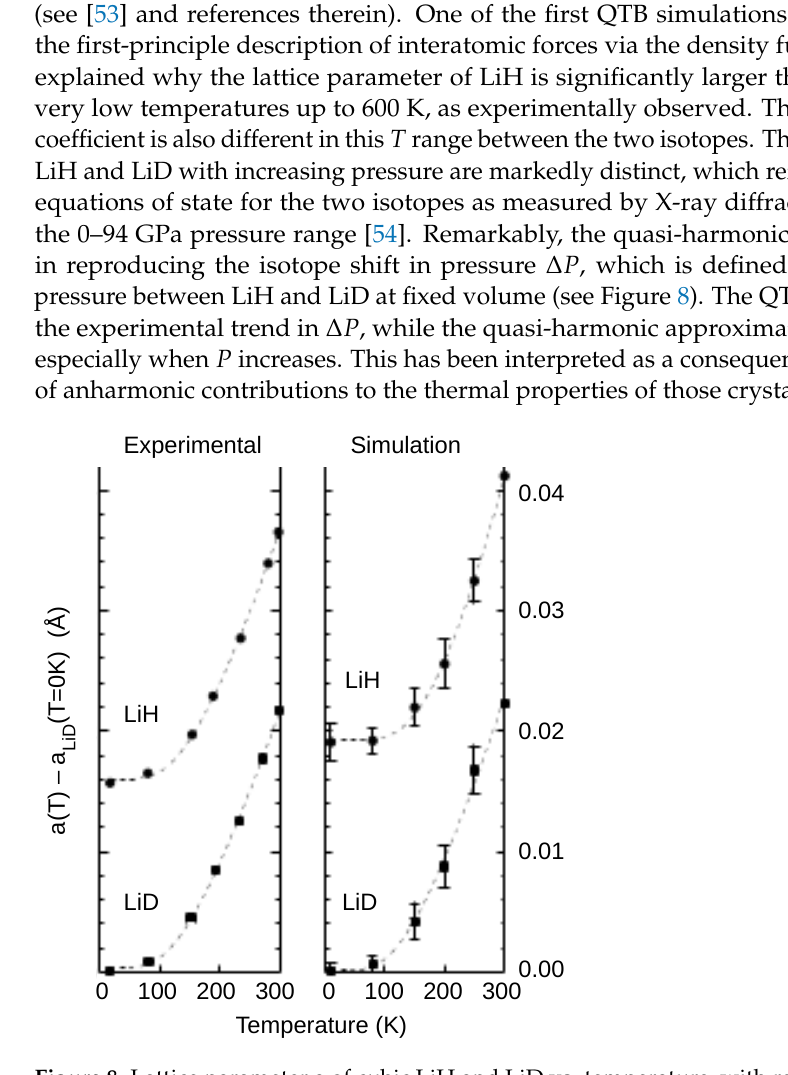
Figure 8. Lattice parameter a of cubic LiH and LiD vs. temperature, with respect to the LiD lattice parameter at T = 0 K. Left —experimental; right —QTB